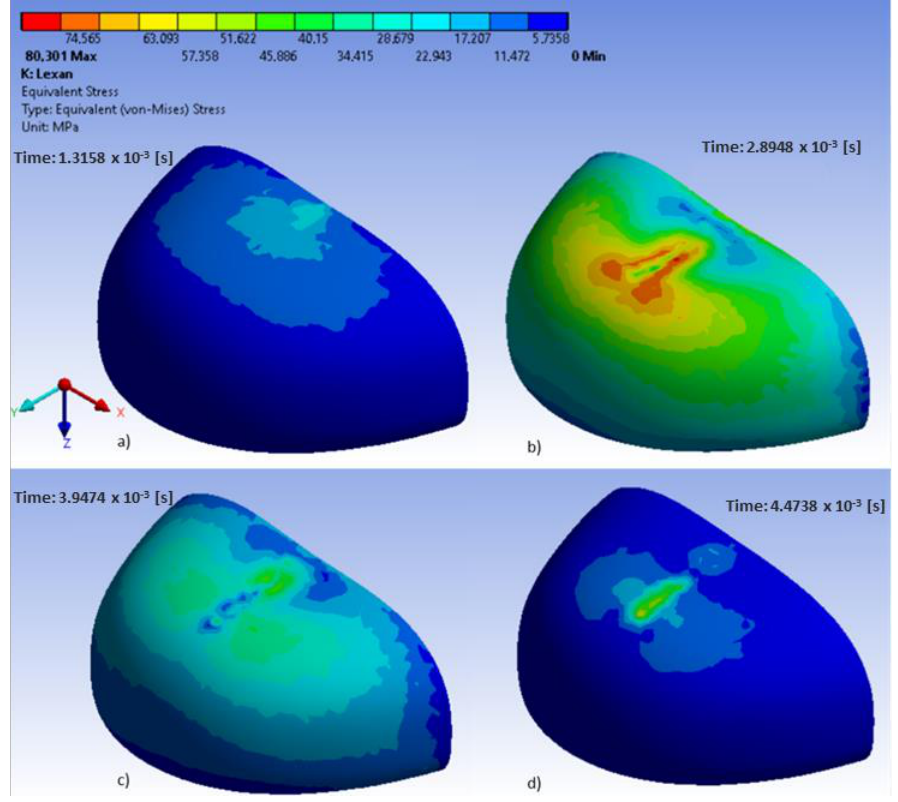
Figure 4. Equivalent stress in polycarbonate toecaps at different time steps: ( a – d ) external side.